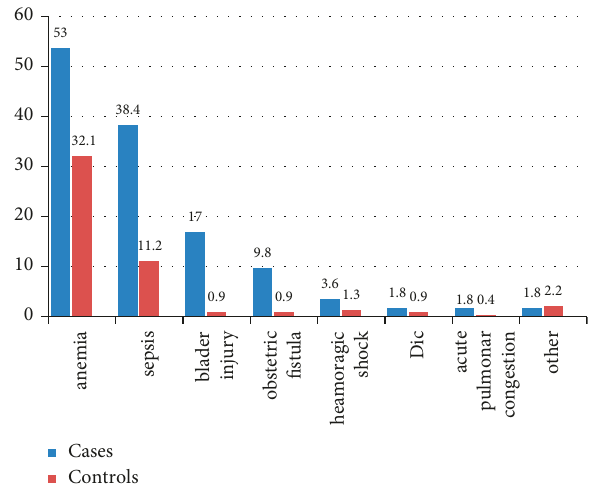
Figure 1: Complications developed in women with uterine rupture and without rupture of uterus in Shire Hospital, North Ethiopia, 2016. ∗ Other complications include urethral ligation, posttrauma psychosis, and foot (9.8%) of mother with uterine rupture developed obstetric